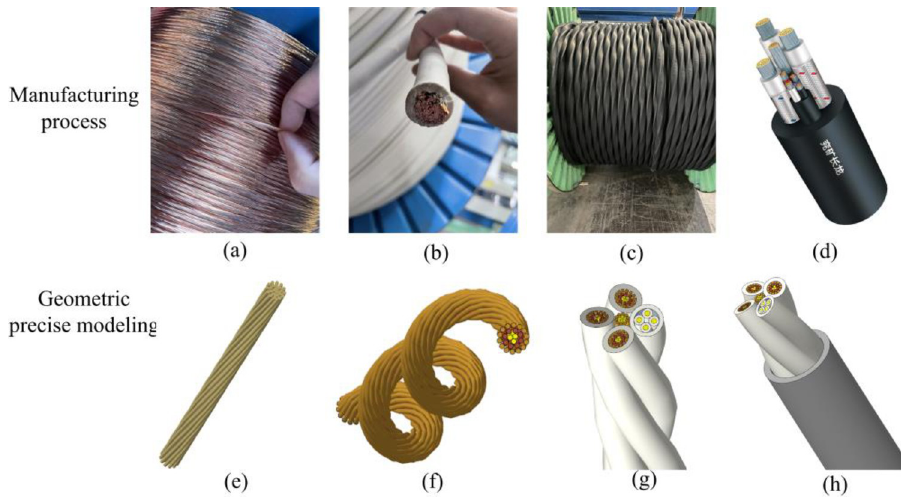
Fig 3. Comparison of manufacturing process and 3D accurate